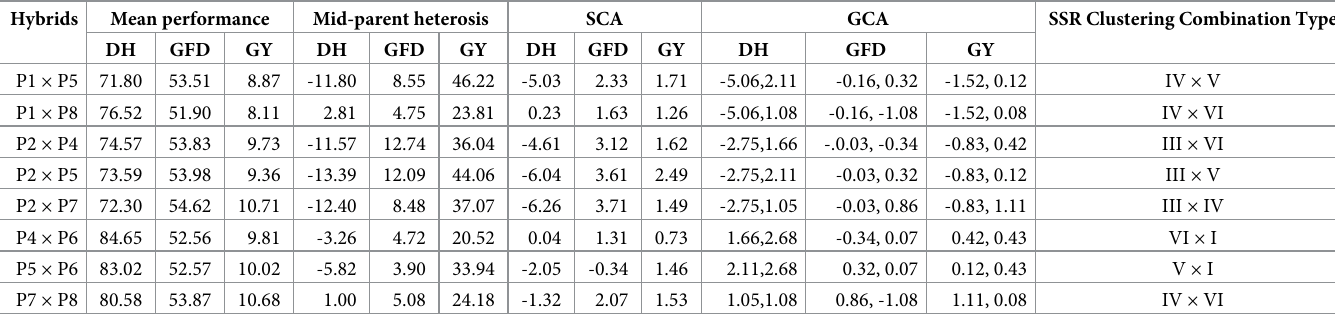
Table 5. Relationship between group division and strong combination yield, mid-parent heterosis, GCA and SCA. Hybrids Mean